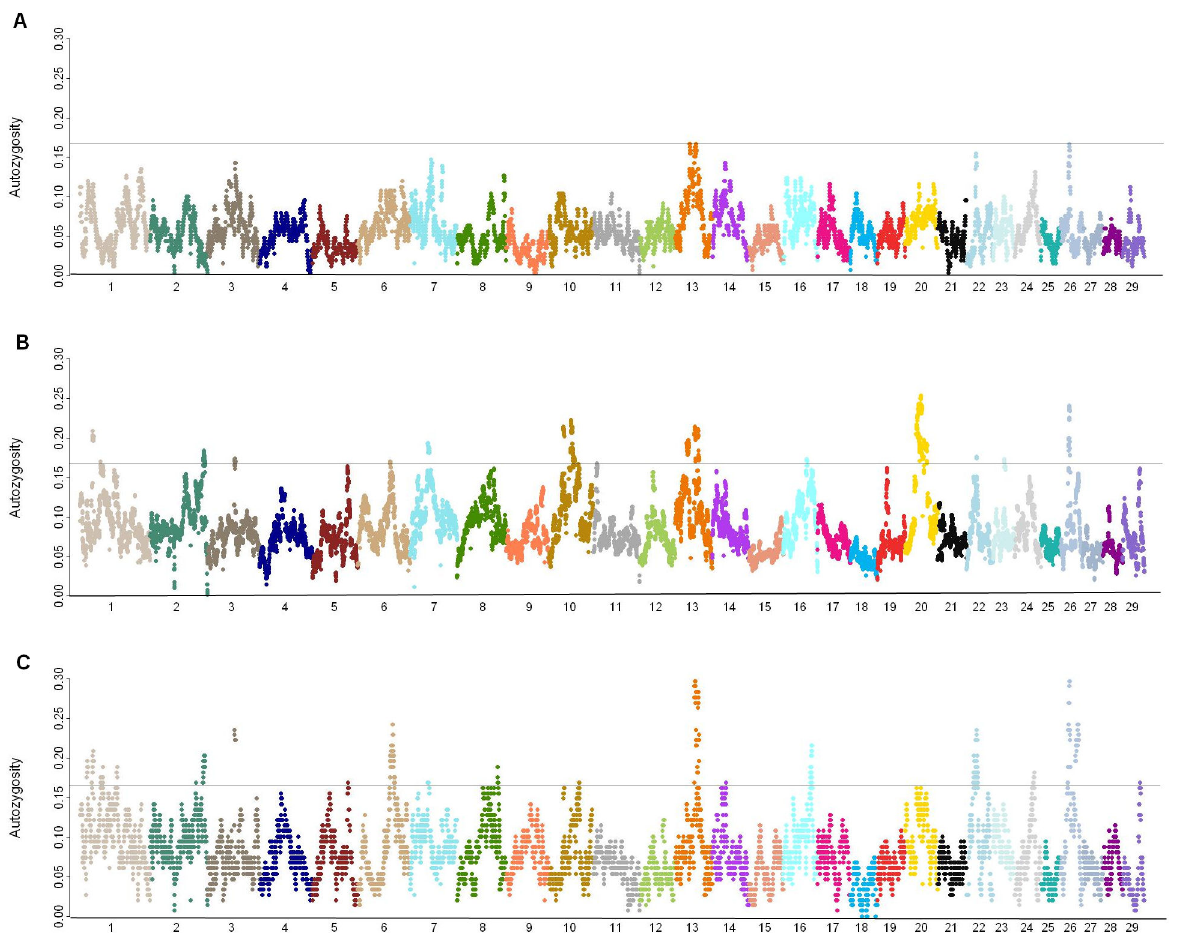
Figure 1. Genome-wide patterns of F within Groups. Manhattan plots of autozygosity were generated using the F L axis) for each SNP locus relative to its genome coordinate (x-axis; Chr indicated) for A) Group I, B) Group II-A, and C) Group II-B. The grey horizintal line indicates the threshold for F > 0.16, which represents approximately the top 2.5% of autozygosity detected. L doi: